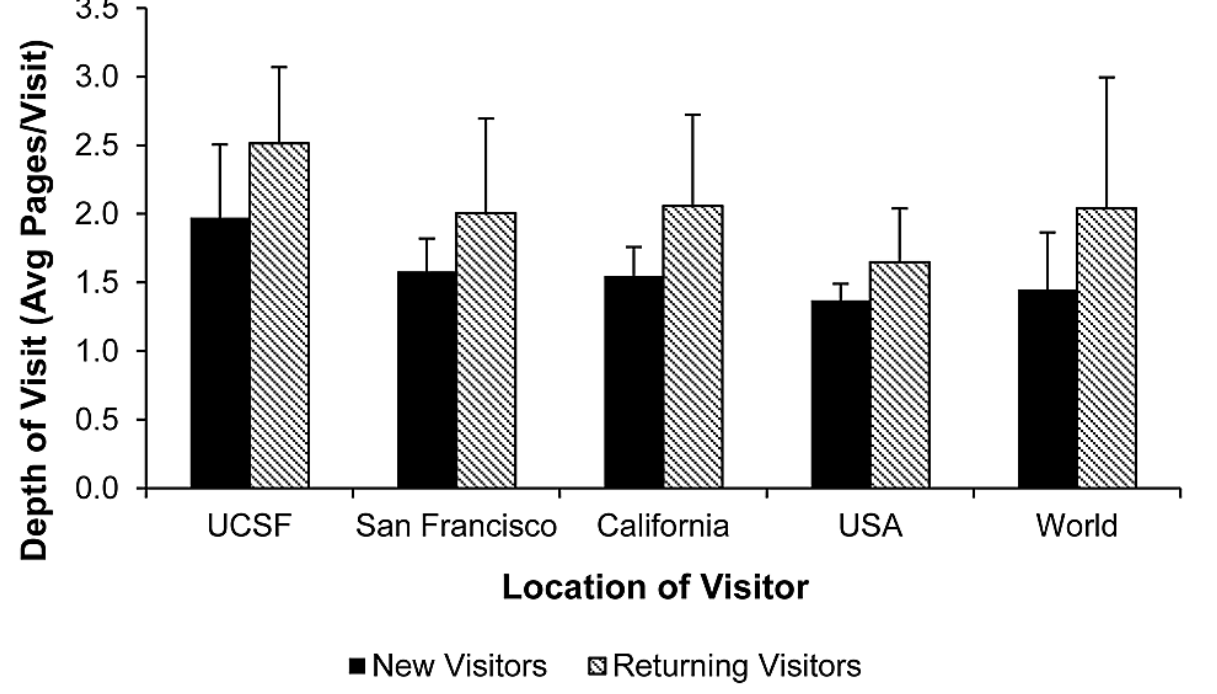
Figure 5. Depth of visit (pages/visit) for new and returning visitors. The figure describes visitors originating from different locations during Months 23-28 from launch. Error bars show 1 Standard